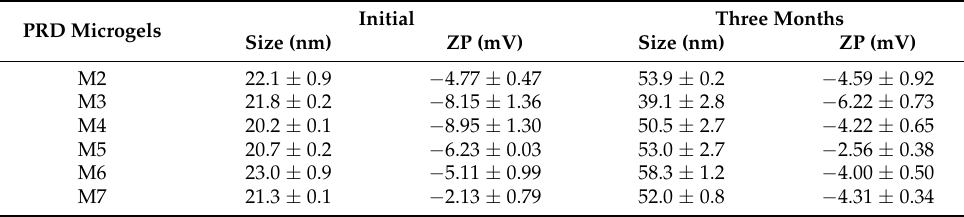
Table 5. Size and zeta potential (ZP) of the mixed polymeric micelle (MPM) of PRD M 2-7 microgels after three months of storage at room temperature. Data are presented as mean ± SD ( n = 3). Initial Three Months PRD Microgels Size (nm) ZP (mV) Size